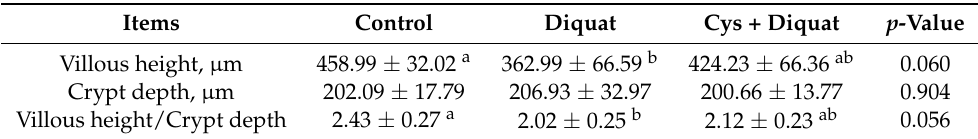
Table 6. Effects of dietary supplementation of coated cysteamine on jejunal morphology of pigs induced by diquat.